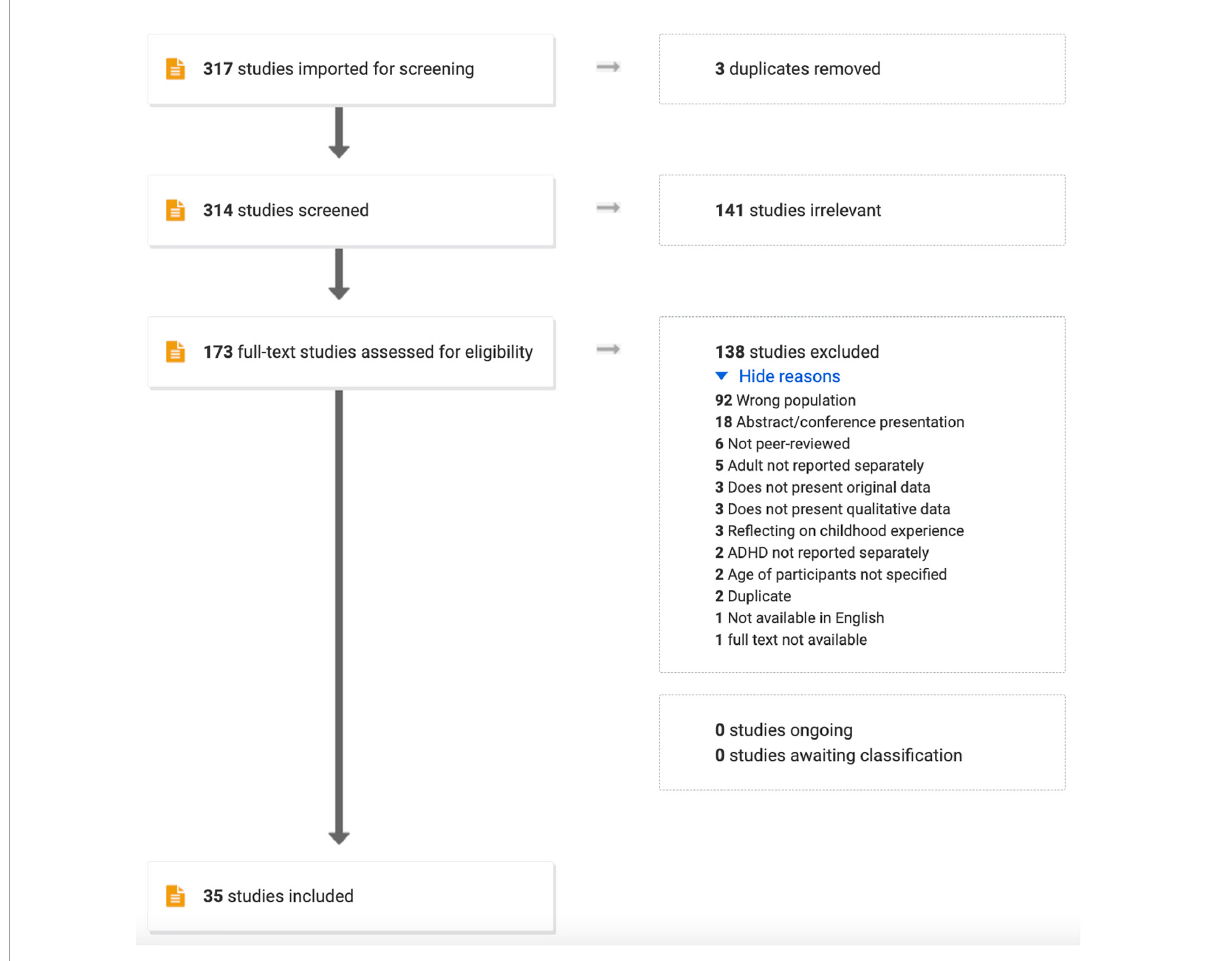
FIGURE1 PRISMA flow diagram showing the search strategy for identifying qualitative studies on the lived experience of adult attention-deficit/hyperactivity disorder